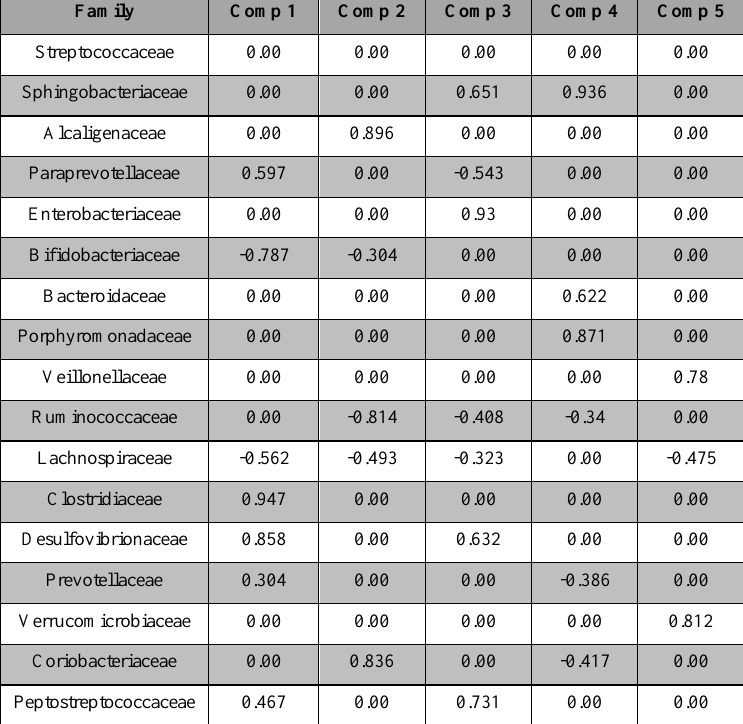
Table 1b. A rotated component matrix for family among control